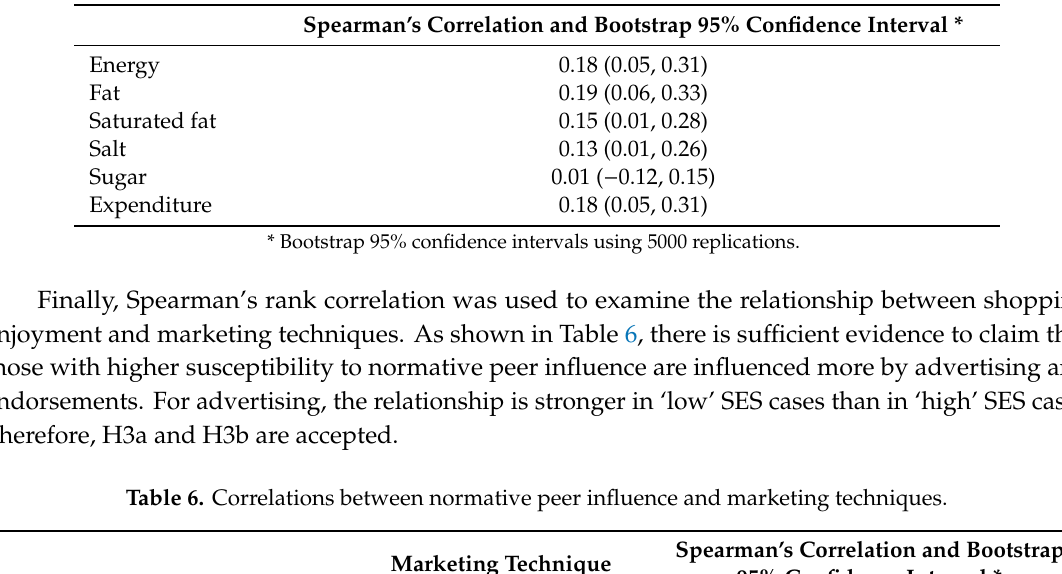
Table 5. Correlations between enjoying shopping with friends, food / drinks intake, and expenditure.